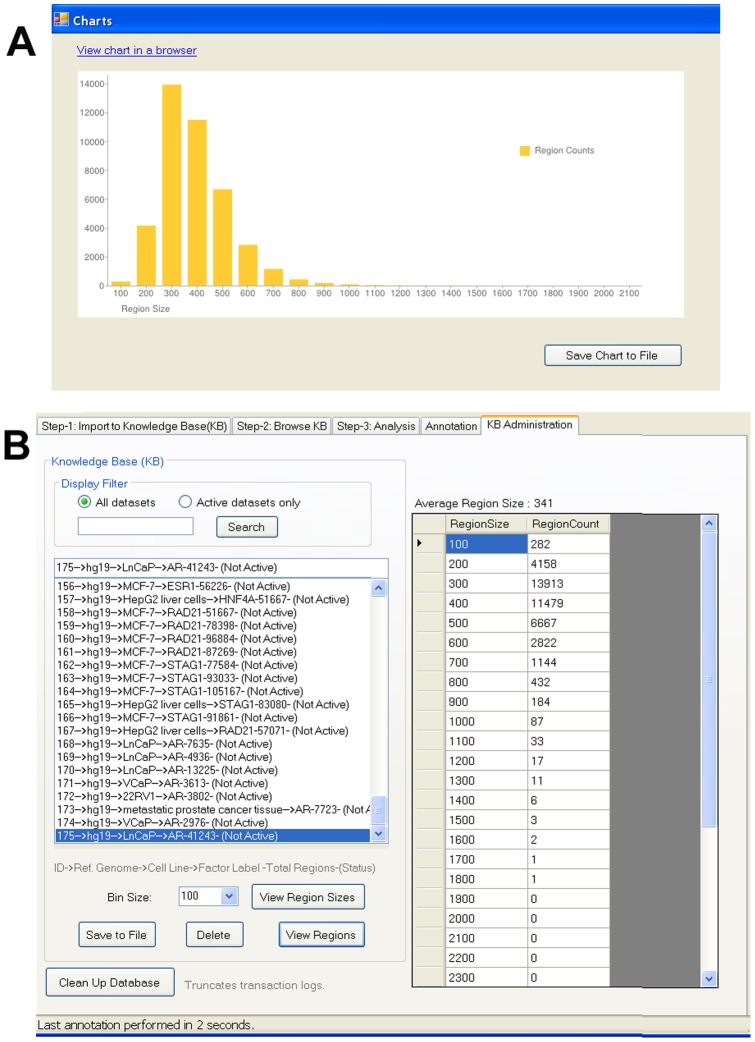
Administration of datasets.From the Administration tab users can delete a dataset, save the data in tab delimited text format, and view the distribution of region sizes over the dataset as a table and histogram.